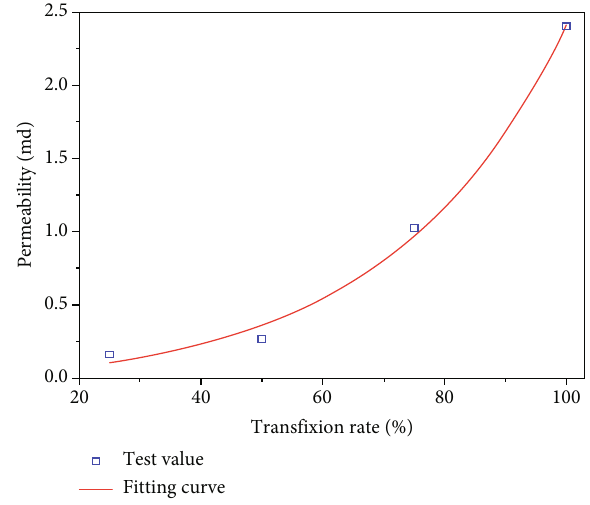
Figure 5: Relationship between permeability and trans fi xion